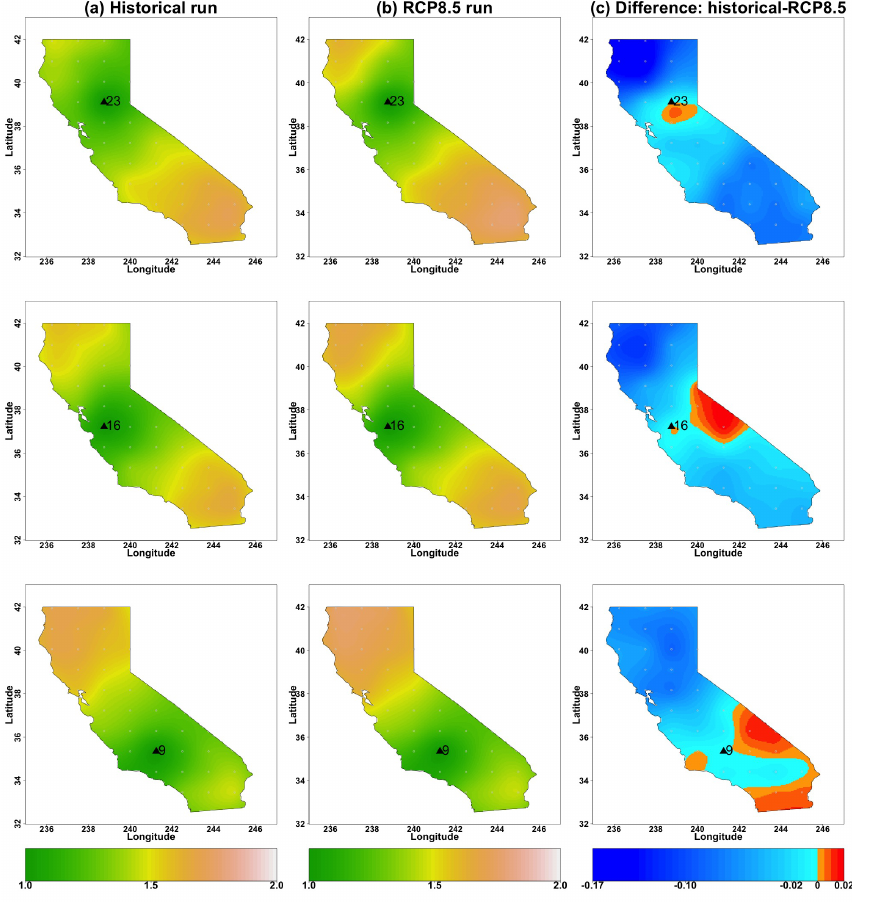
Figure 6. Ensemble means of pairwise extremal coefficients of annual maximum AR precipitation from a focal grid point (black triangle; grid locations 23, 16, and 9 from top to bottom) to other locations in California for CMIP5 multi-models. Changes are shown over